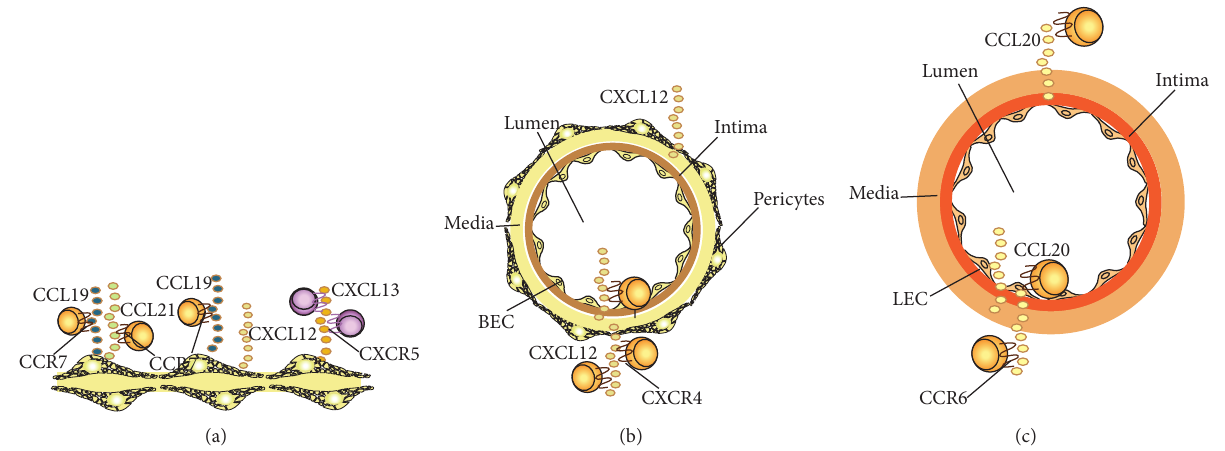
Figure 3: Chemokine production by FRC and endothelial subsets according to Malhotra et al. [28]. (a) FRCs are able to secrete CCL19, CCL21 the ligand of CCR7, CXCL12 ligand of CXCR4, and CXCL13 ligand of CXCR5. (b) BECs express CXCL12 the ligand of CXCR4. (c) LECs express CCL20 the ligand of CCR6.